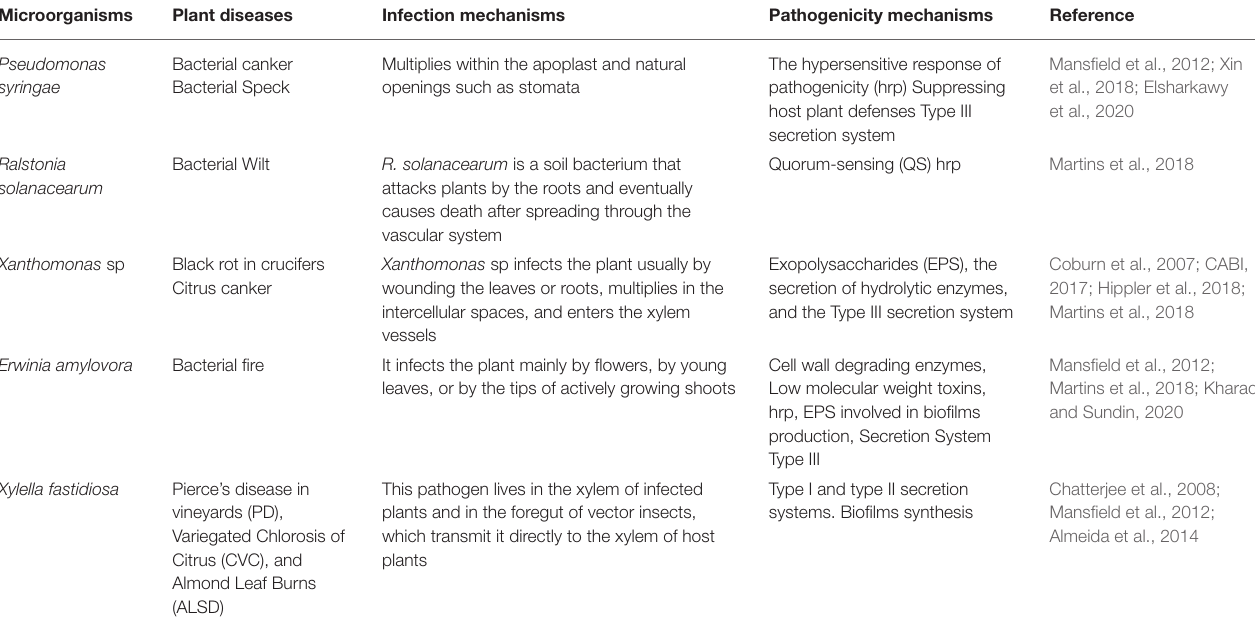
TABLE 1 | Major phytopathogenic bacteria with a critical impact in agriculture. Microorganisms